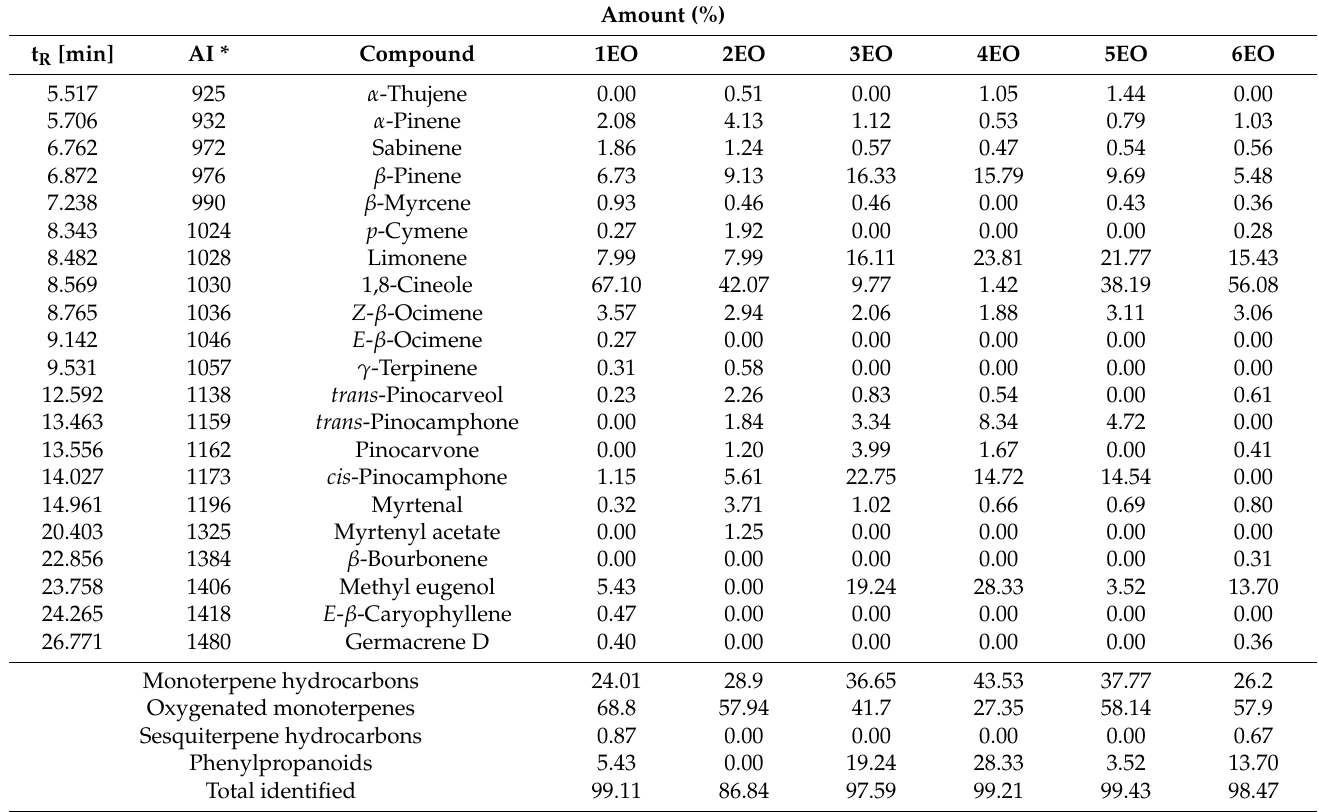
Table 2. Essential oil composition of Hyssopus officinalis subsp. aristatus . * Arithmetic retention